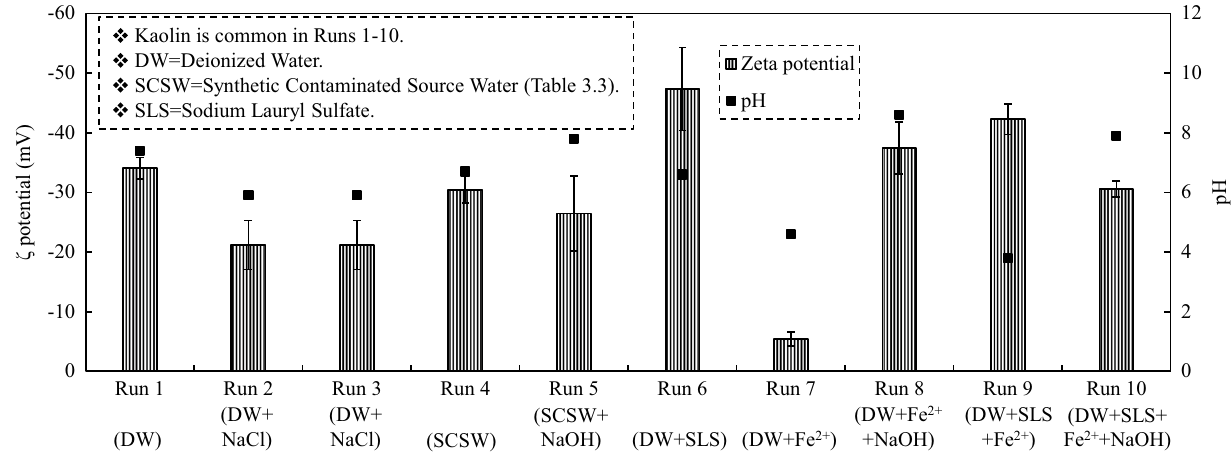
Fig. 3 Zeta potential characteristics of Runs 1–10, where kaolin was used as a model of common microparticles in Runs 1–10, sodium lauryl sulfate was used in Runs 6, 9, and 10, and Fe was used in Runs 7–10. The error bars depict the unbiased standard